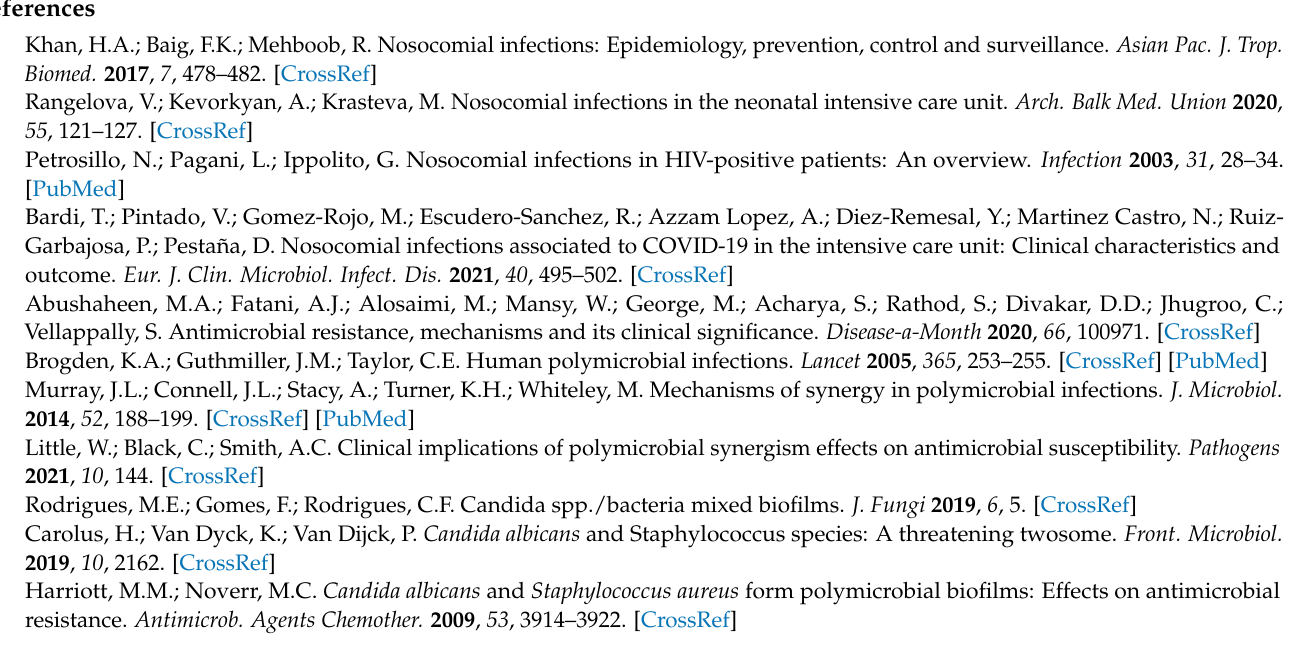
and FICI values of benzalkonium chloride (BAC) in combination with either ( − )-myrtenol or (+)- myrtenol (expressed in µ g/mL) against various isolates of S. aureus . Table S4. Biofilm preventing concentrations (BPC), fractional biofilm preventing concentrations, and FICI values of benzalkonium chloride (BAC) in combination with either ( − )-myrtenol or (+)myrtenol (expressed in µ g/mL) against various isolates of S. aureus . Table S5. MIC, FIC, and FICI values of fluconazole in combination with either ( − )-myrtenol or (+)-myrtenol (expressed in µ g/mL) against various isolates of C. albicans . Table S6. Biofilm preventing concentrations (BPC), fractional biofilm preventing concentrations, and FICI values of fluconazole in combination with either ( − )-myrtenol or (+)-myrtenol (expressed in µ g/mL) against various isolates of C. albicans . Table S7. MIC, FIC, and FICI values of benzalkonium chloride (BAC) in combination with either ( − )-myrtenol or (+)-myrtenol (expressed in µ g/mL) against various isolates of C. albicans . Table S8. Biofilm preventing concentrations (BPC), fractional biofilm preventing concentrations, and FICI values of benzalkonium chloride (BAC) in combination with either ( − )-myrtenol or (+)-myrtenol (expressed in µ g/mL) against various isolates of C. albicans